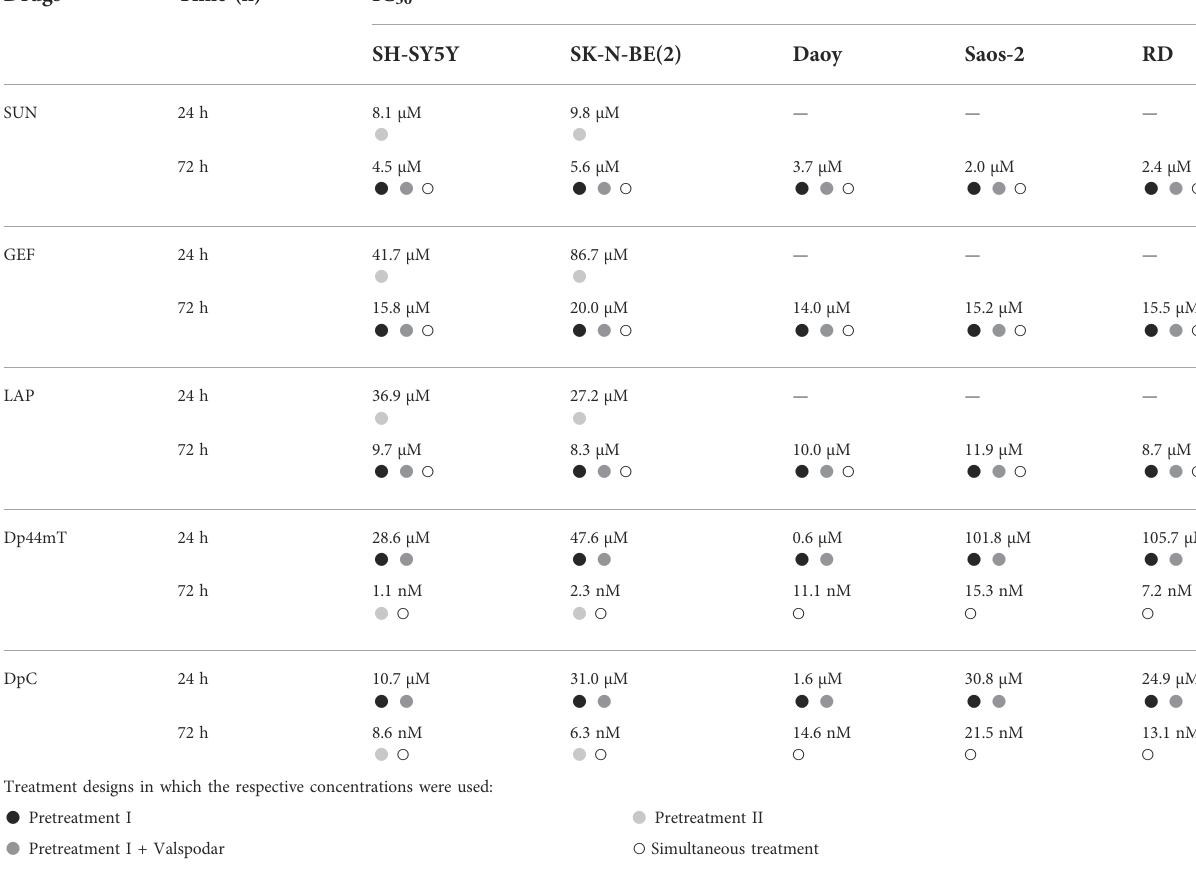
TABLE 2 The IC 50 values.The concentrations ofthe drugs correspondingto a reduction in cellproliferationby 50%. The IC 50 values were determined for each cell line after incubation with TKIs (SUN, GEF, and LAP) and thiosemicarbazones (Dp44mT and DpC) alone for 72 and/or 24 h at 37 °